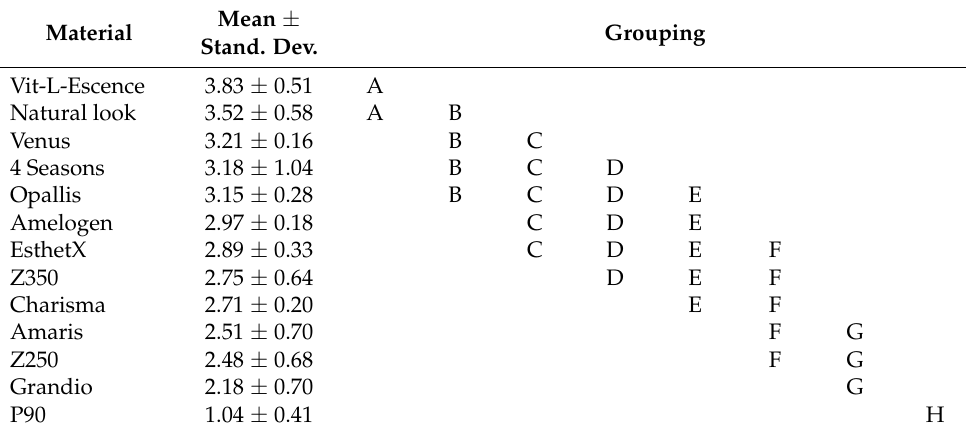
The interaction between both factors was also significant (Table 3). Table 2. Mean and standard deviation for the volumetric shrinkage according to the factor resin